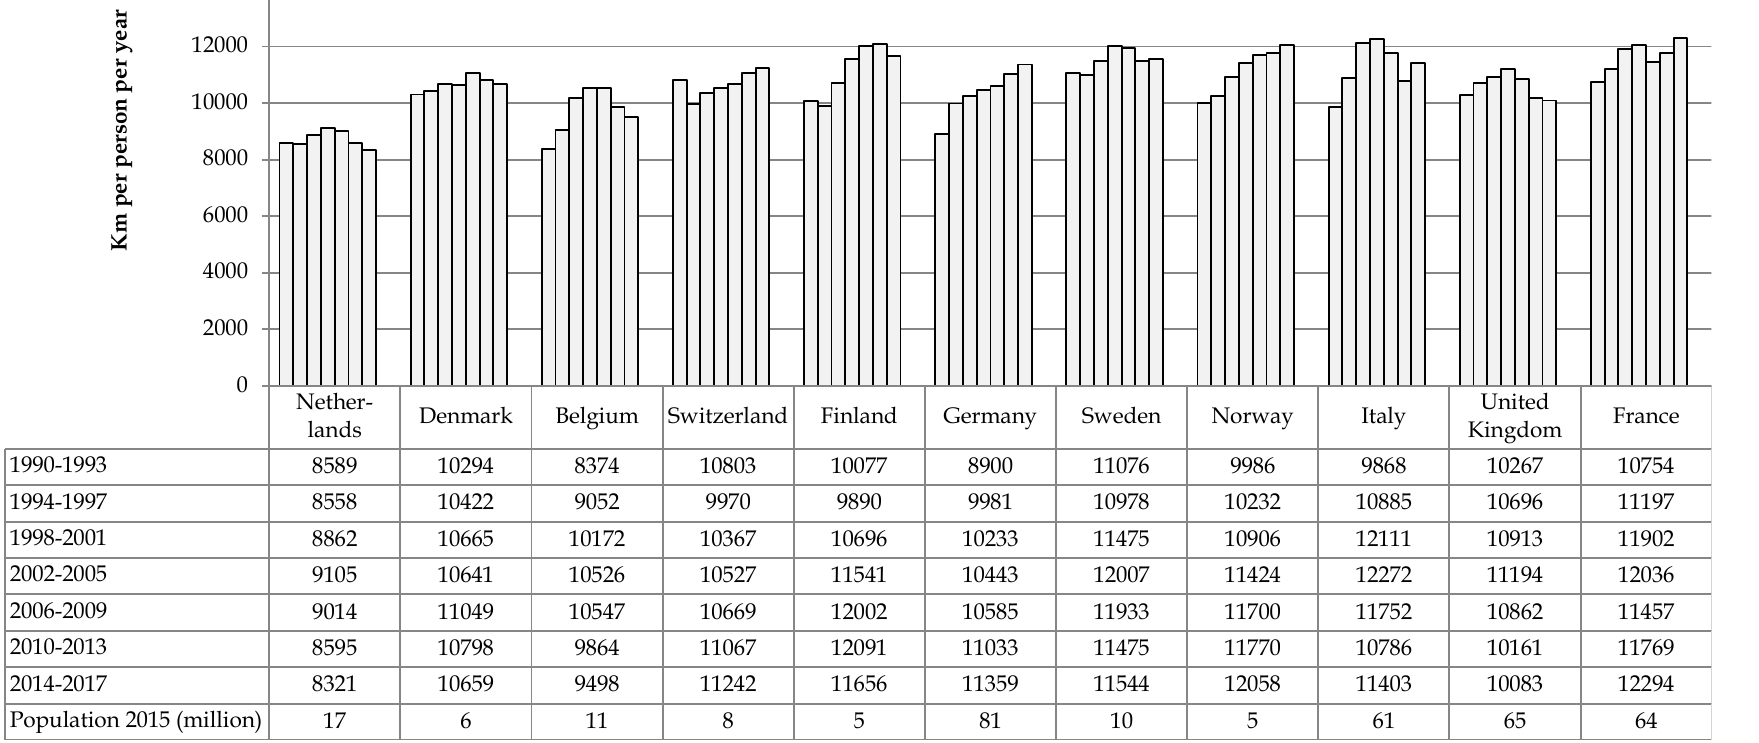
Figure 10. Distance travelled by passenger cars per capita per year between 1990 and 2017, and population size in 2015 (OECD/ITF,